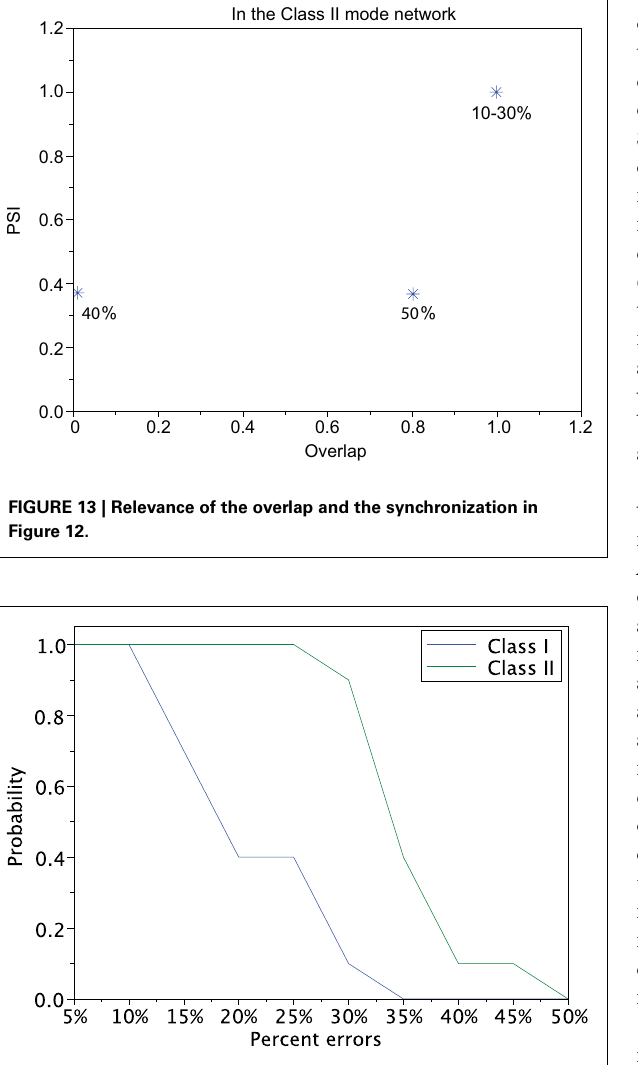
FIGURE 14 | Retrieving probability for the Class I and II mode networks. Randomly generated 12 sets of patterns based of the 4 stored patterns ( Figure 8A ) were used as the